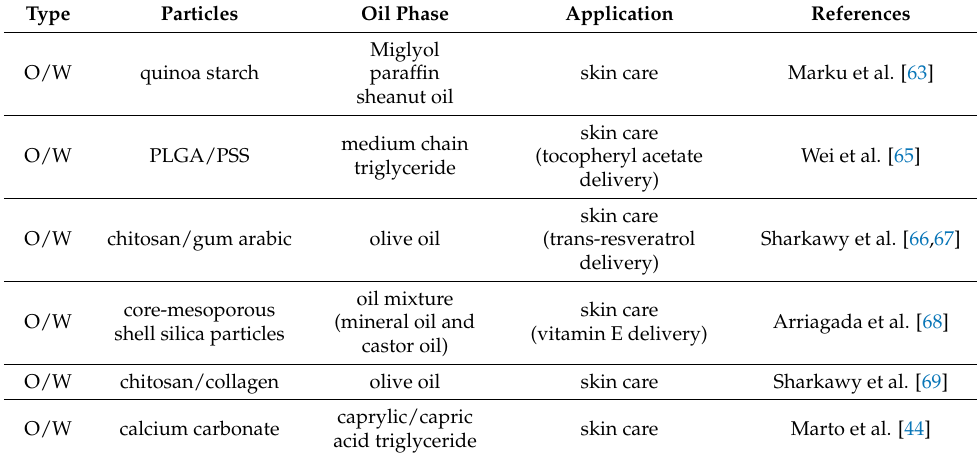
Table 1. Summary of Pickering emulsions studied for their cosmetic interest, and their potential